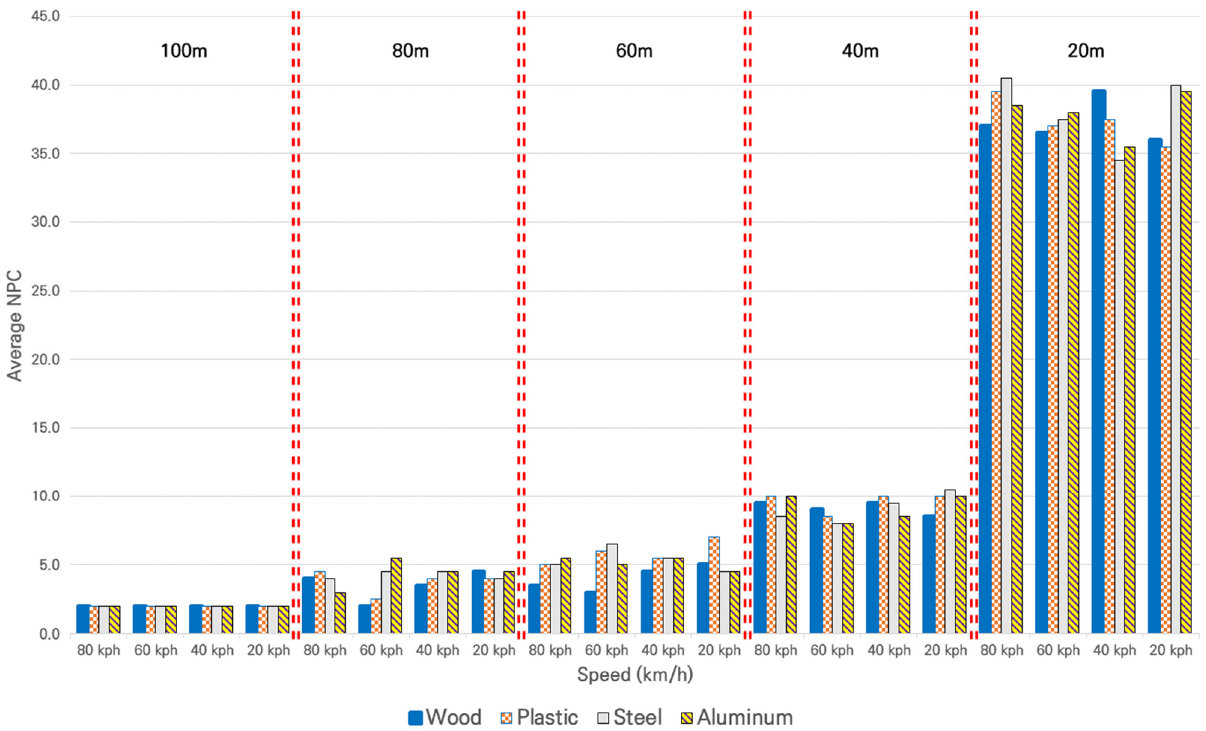
Figure 7. Average of NPC for different materials at each distance and speed on a sunny day.